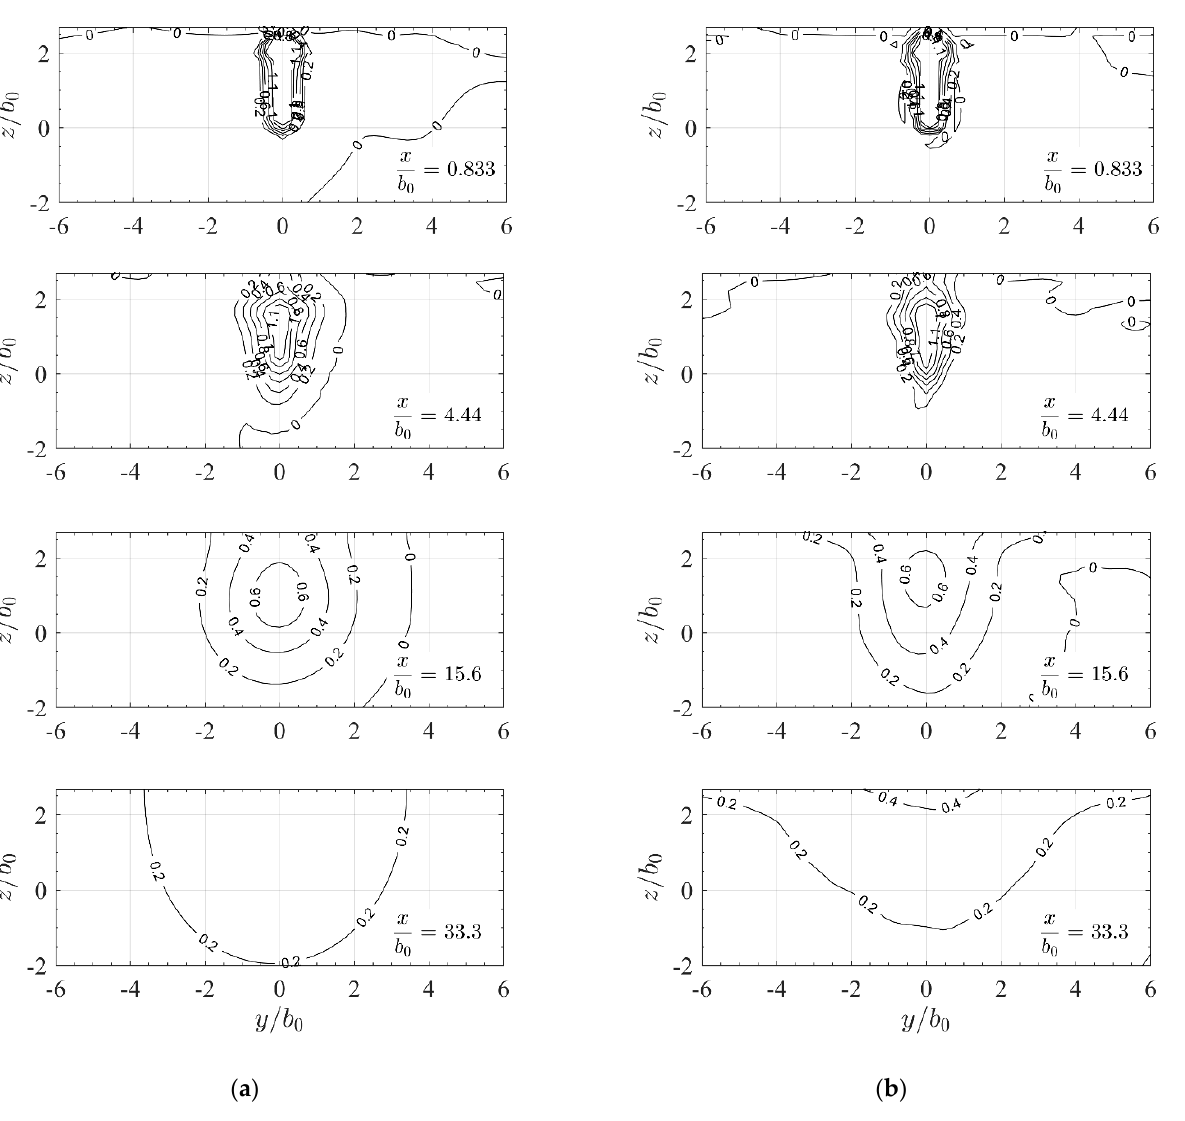
Figure 8. Channel jet showing isolines of the normalized streamwise velocity component 𝑢/𝑢 (cid:2868) in yz-sections with relative distances 𝑥/𝑏 (cid:2868) from the orifice as simulated for ( a ) ch-rans and ( b ) ch-des channel configuration. Distances 𝑦 and 𝑧 are normalized with channel/slot width 𝑏 (cid:2868) .